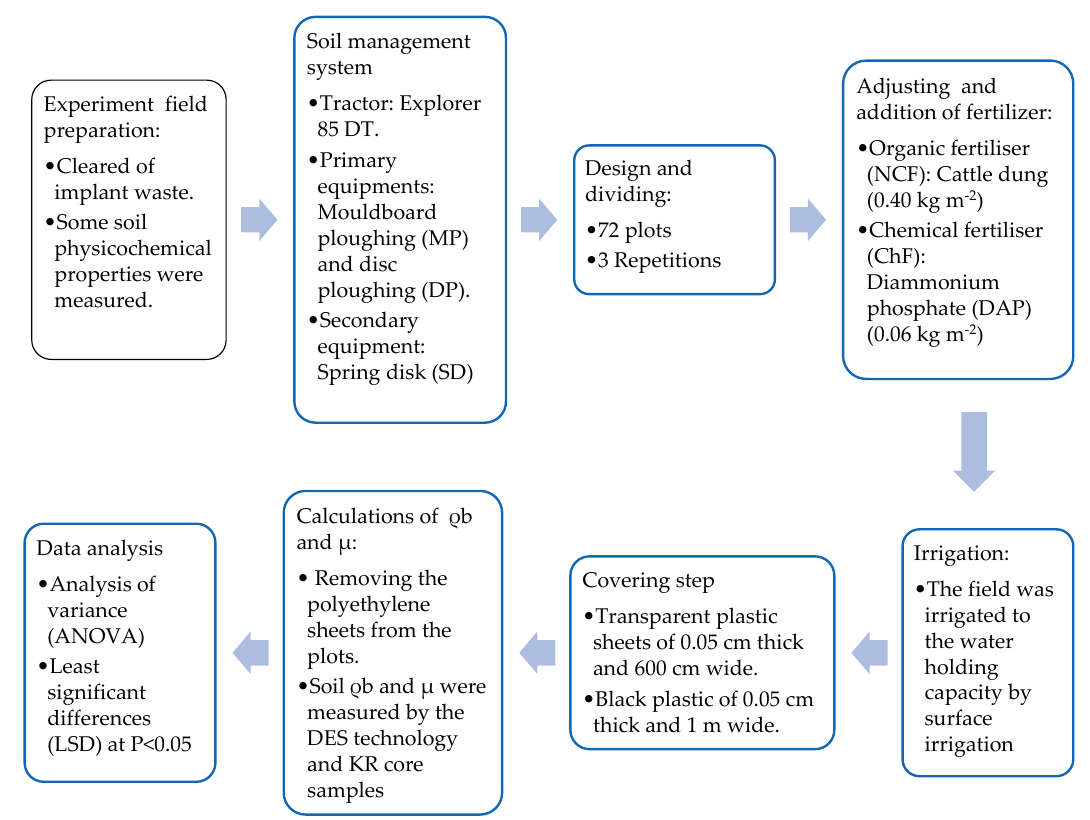
Figure 1. Experimental workflow chart [17,53].